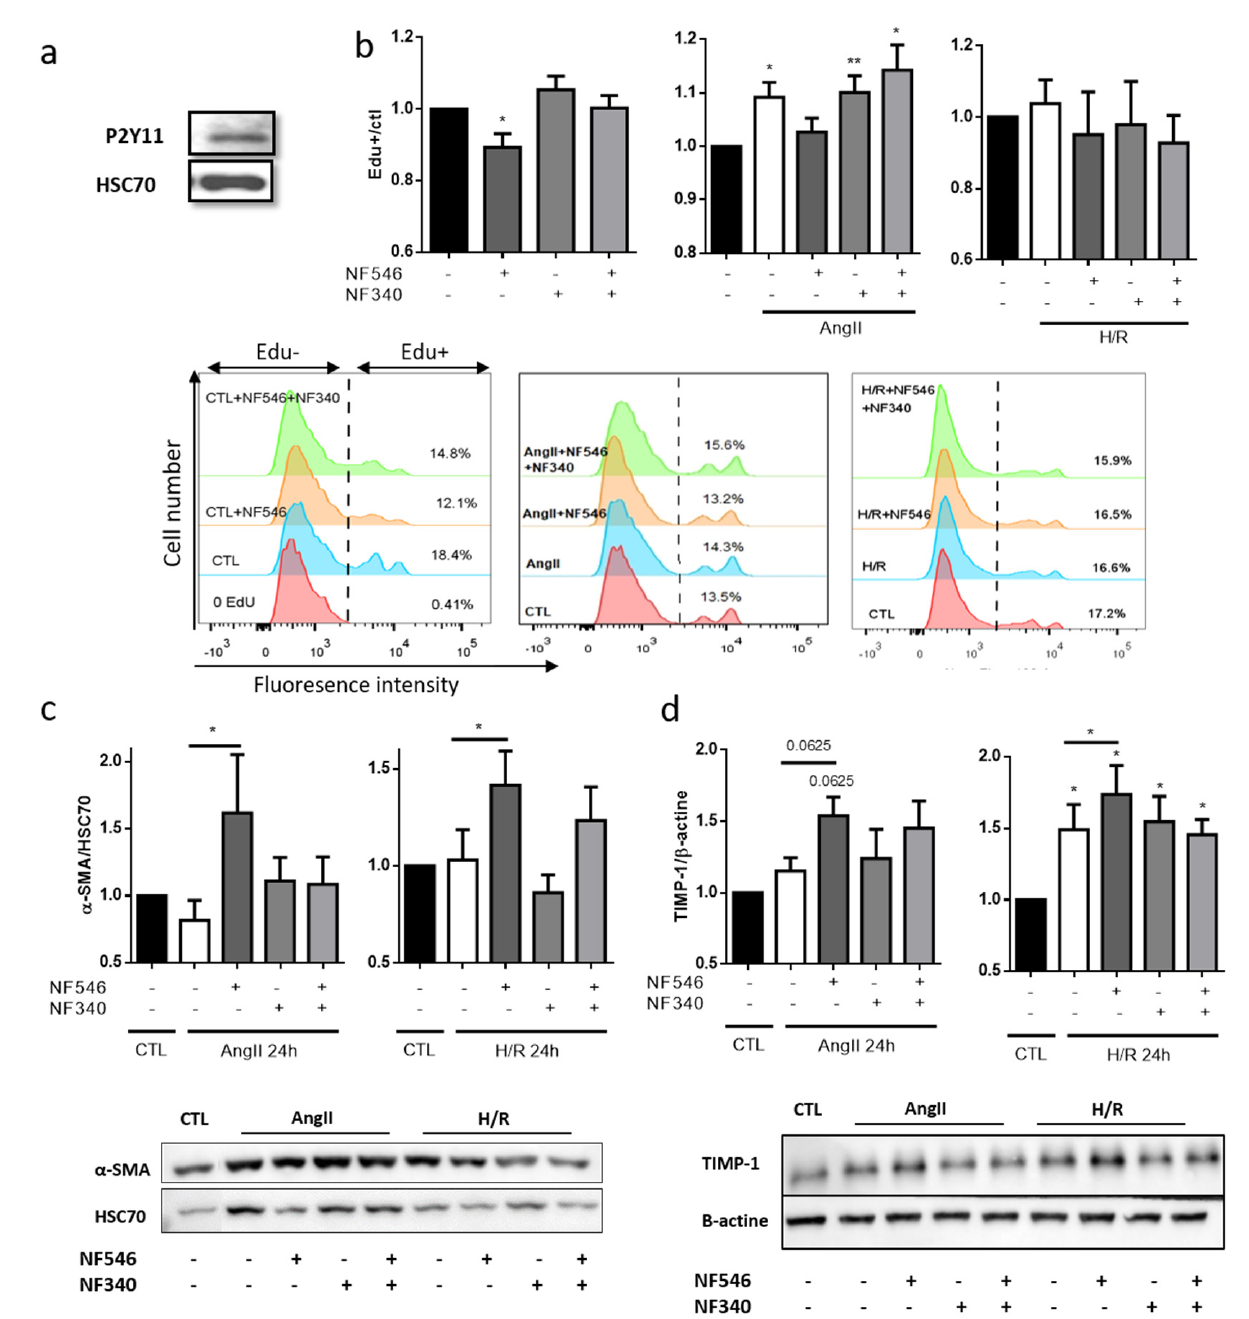
Figure 5. P2Y11R activation reduces SMC switch towards synthetic phenotype. ( a ) P2Y11R expression on HCASMC was analyzed by western blot. We observed a band at 50 kda with P2Y11R antibody. ( b ) HCASMC proliferation was assessed by EdU incorporation during 72 h, and P2Y11R was modulated by NF546 (10 µM) and NF340 (10 µM). Under basal condition, NF546 significantly decreased HCASMC proliferation (n = 9). AngII (100 nM) incubation significantly increased HCASMC proliferation, while NF546 decreased this AngII-induced proliferation (n = 9). Previous exposure to 5 h hypoxia did not modify HCASMC proliferation, and neither NF546 nor NF340 induced differences in proliferation (n = 5). ( c – f ) HCASMC phenotype was determined according to the expression of α -SMA and TIMP-1 (contractile) after 24 h, evaluated by western blot. ( c,d ) In AngII and H/R groups, NF546 increased α -SMA and TIMP-1 expression (n = 5–8). * p < 0.05 and ** p < 0.01, compared to CTL condition, if not indicated. Data given as mean ± SEM. 2.9. P2Y11 Activation Prevents SMC Proliferation Induced by Endothelial Cells Exposed to HR